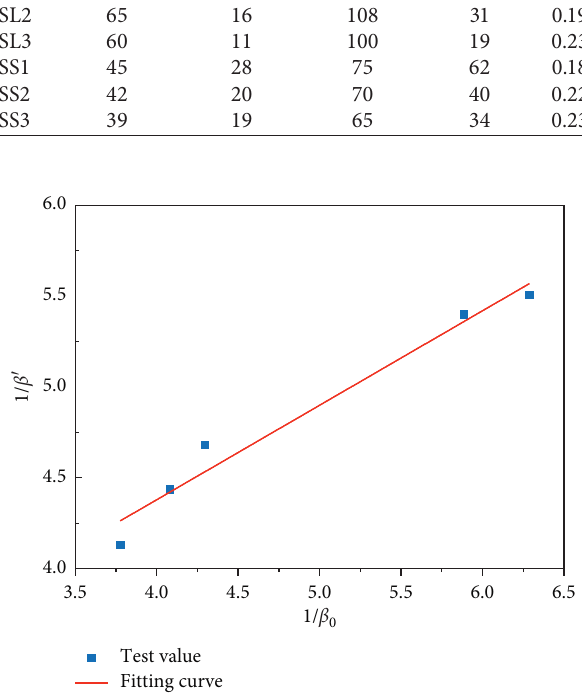
Figure 8: Relationship between 1/ β ′ and 1/ β